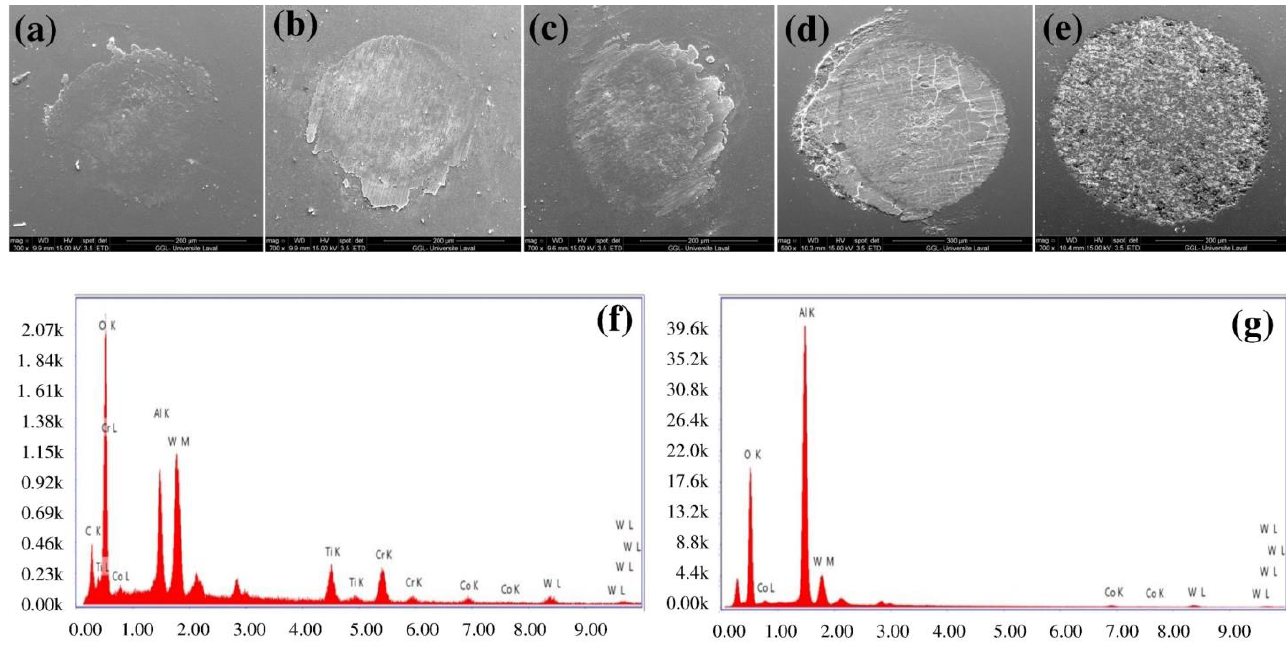
Figure 19. SEM micrographs of worn alumina balls at sliding speed of 50 mm/s against ( a ) CrN/CrCN/DLC, ( b ) CrN/AlTiN, ( c ) CrN/CrCN, ( d ) CrCN/TiSiCN, and ( e ) uncoated WC-Co substrate, EDS analysis of the balls used for: ( f ) CrCN/TiSiCN coating and ( g ) uncoated substrate.